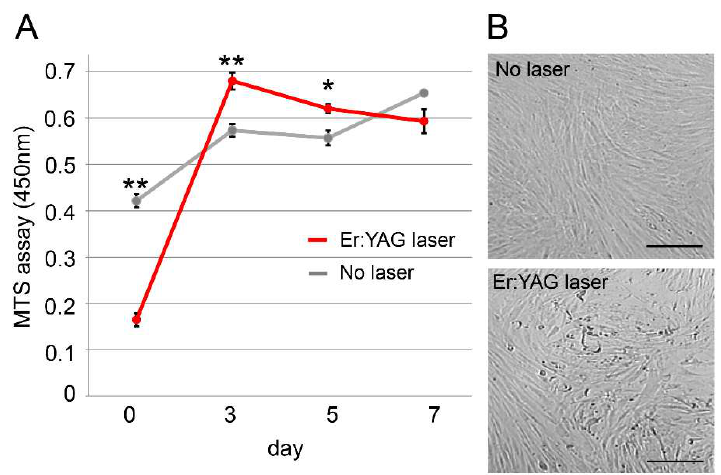
Figure A4. Effect of Er:YAG-LI on HPDL cells proliferation incubated for different periods [41]. ( A )